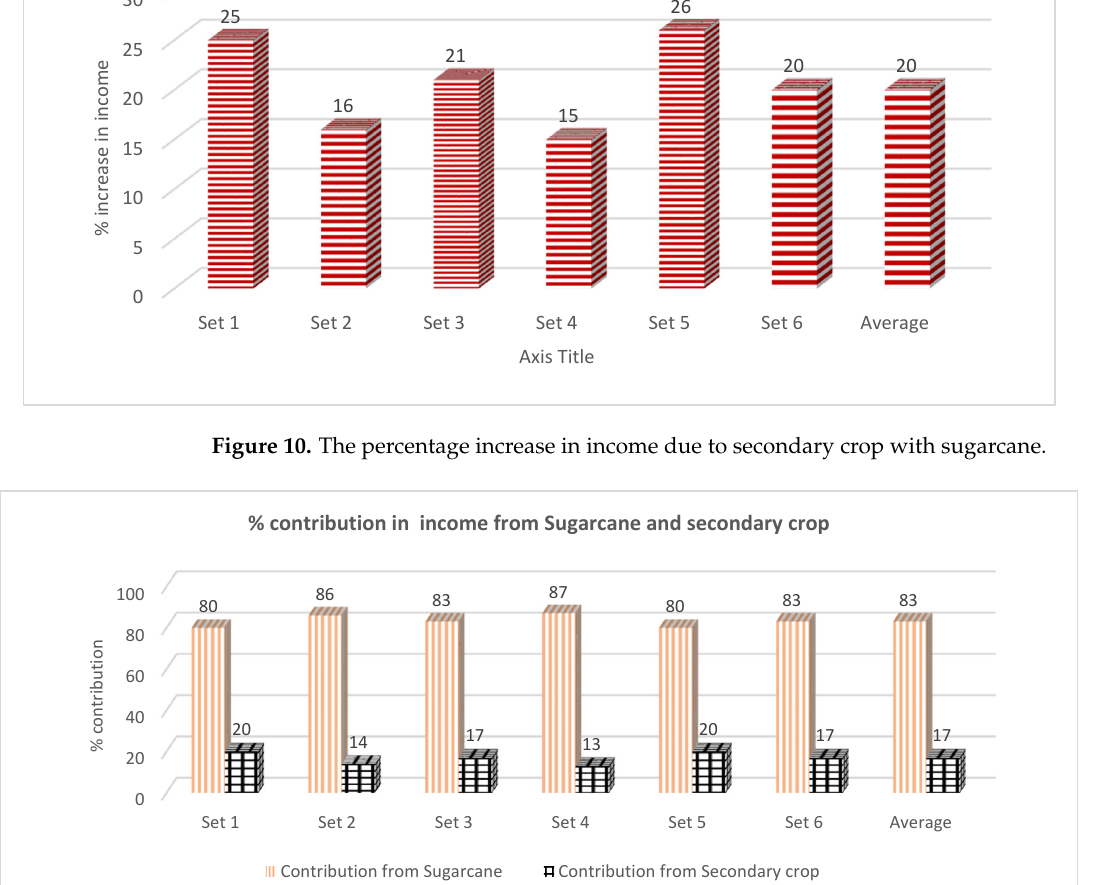
Figure 11. The percentage contribution of sugarcane and secondary crops in total income.